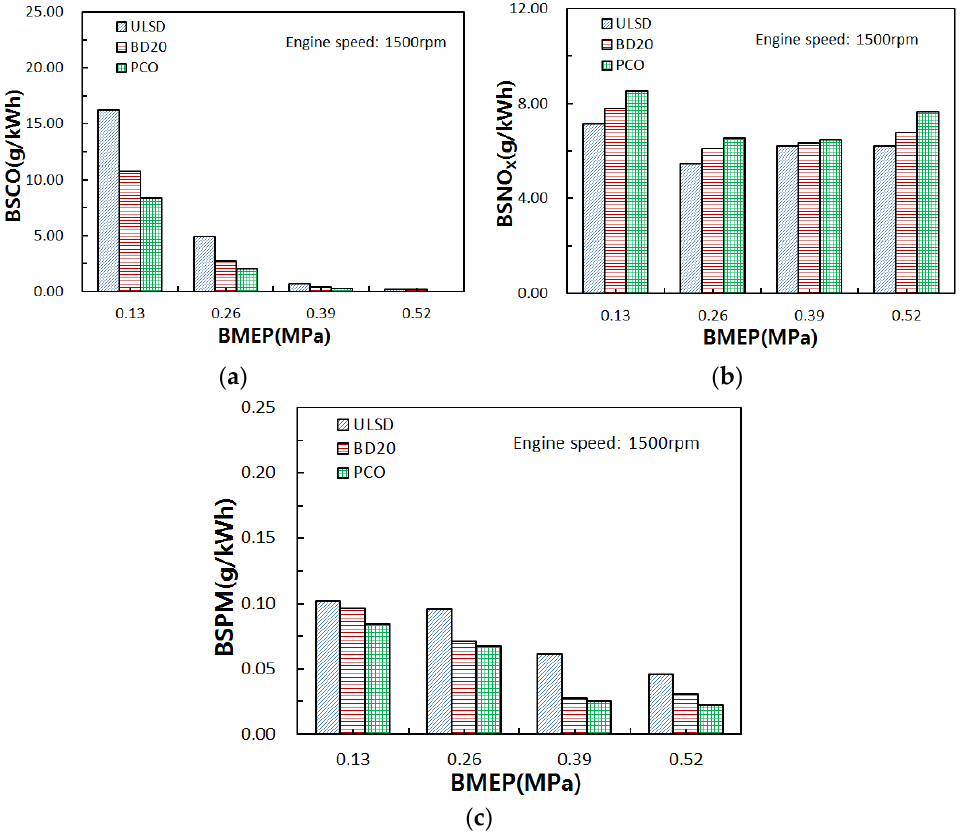
Figure 8. Effect of test fuels on exhaust emissions according to BMEP. ( a ) CO; ( b ) NO x ; ( c ) PM (particulate matter).